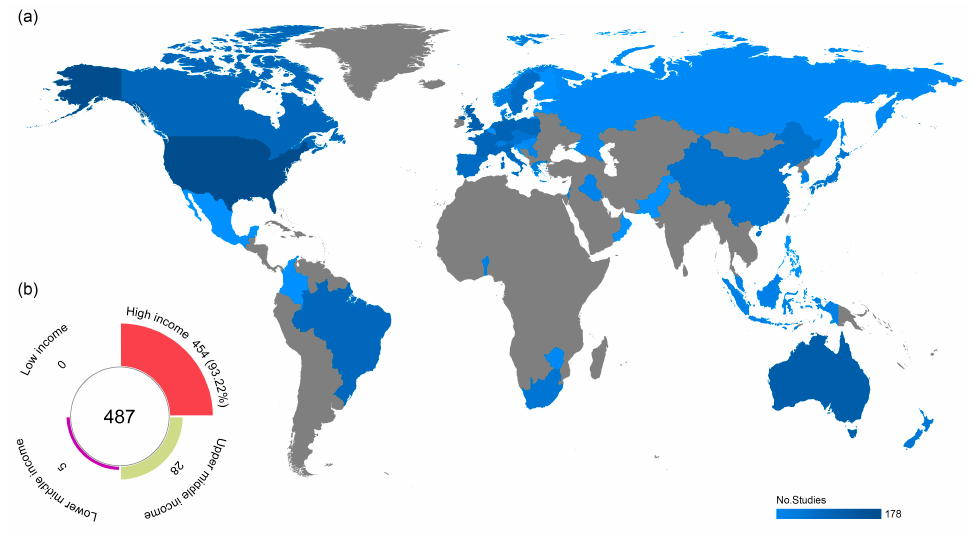
Figure 4. ( a ) Global distribution of community gardens research, ( b ) the number of publications by income groups as defined by the World Bank.